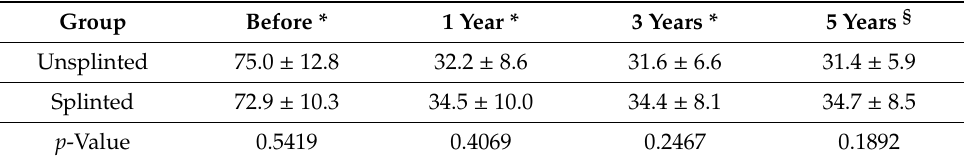
Table 3. Oral Health Impact Profile.